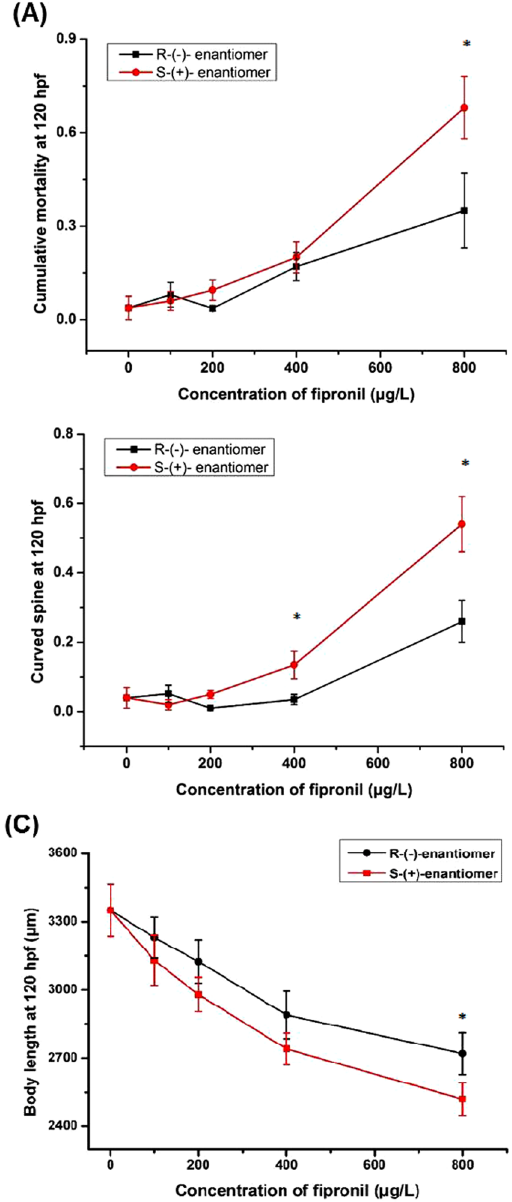
Figure 1. Enantioselective developmental toxicity of fipronil in zebrafish embryo-larvae. Zebrafish embryos were treated with fipronil ( + , − ) at different concentrations for 120 hpf (n = 32). The mortalities ( A ), curved spines ( B ) and body lengths ( C ) of embryo-larva were